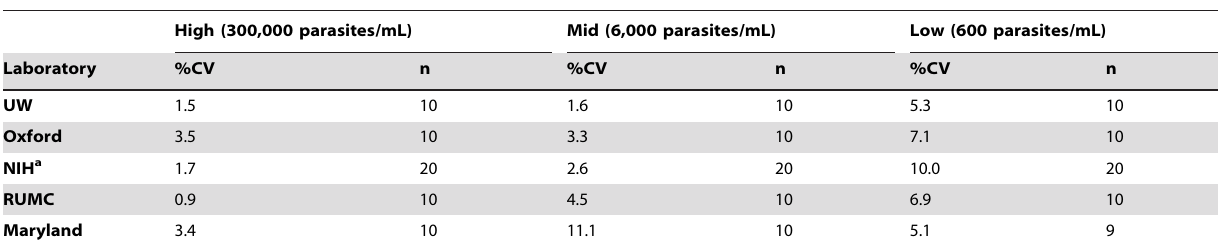
Table 4. Precision statistics by